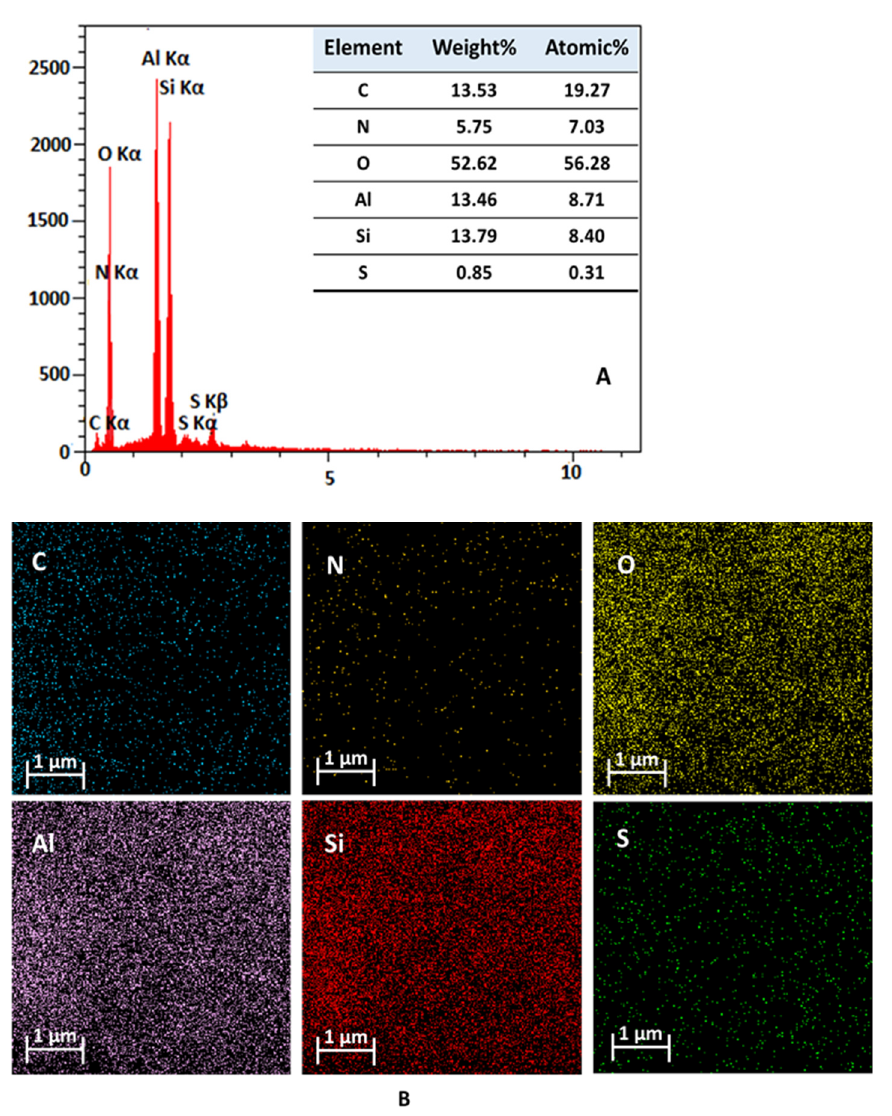
Figure 4 . ( A ) EDS and ( B ) elemental mapping analyses of Hal-Py-IL . Figure 4. ( A ) EDS and ( B ) elemental mapping analyses of Hal-Py-IL.